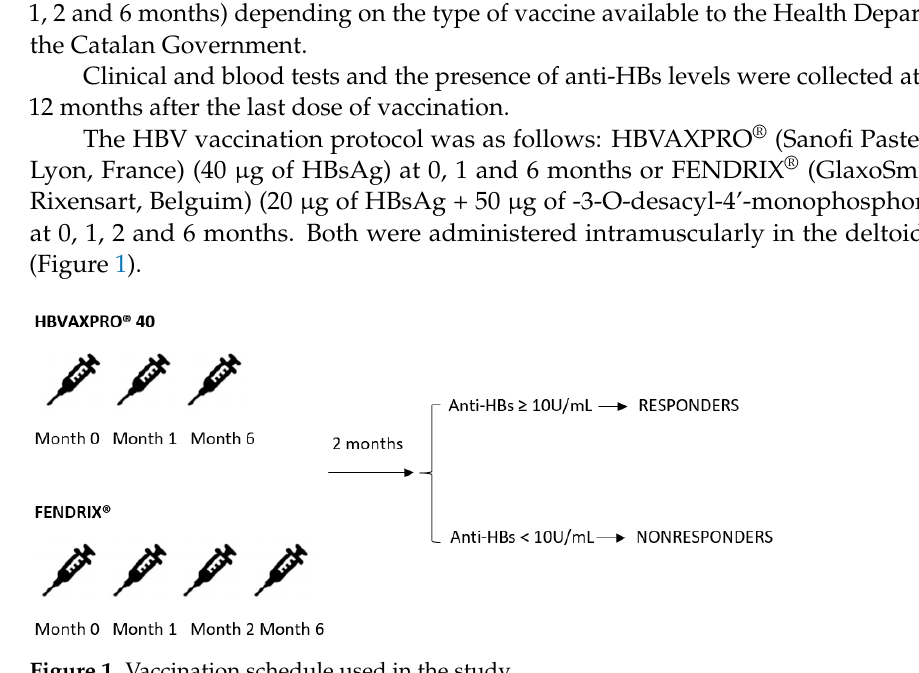
Figure 1. Vaccination schedule used in the study.